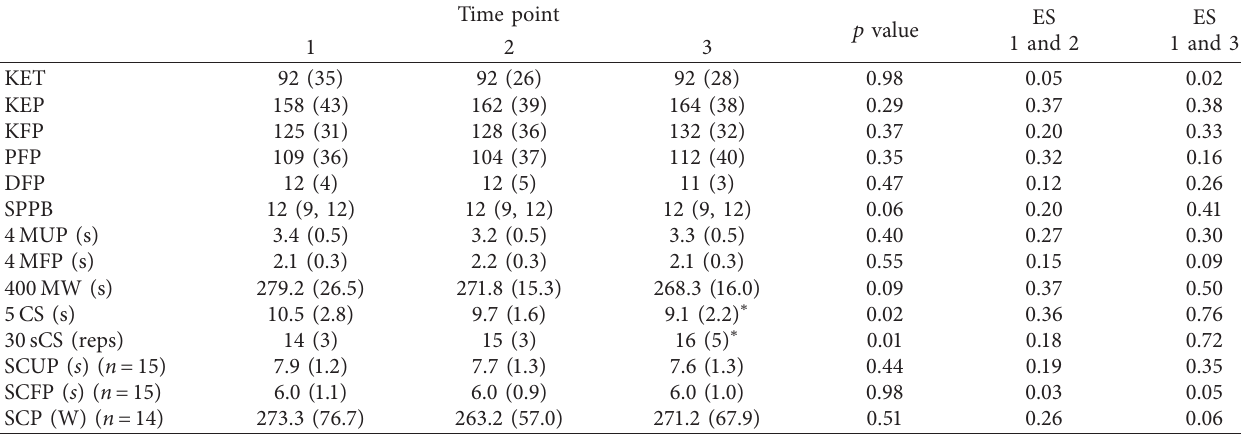
Table 2: Muscle torque ( n � 14), power ( n � 13), and functional performance ( n � 16) for time points 1 (week 0), 2 (week 9), and 3 (week 15).